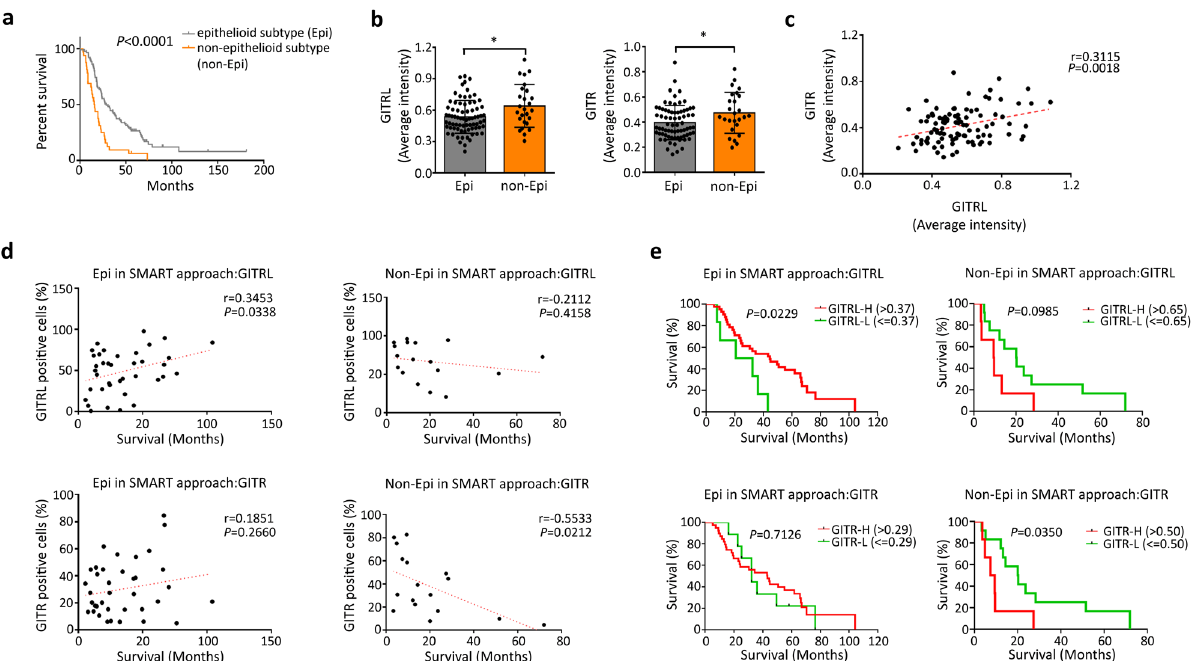
Fig. 6 GITR/GITRL were highly expressed in nonepithelioid MPM and negatively correlated with survival after the SMART approach. a Kaplan – Meier survival analysis of all MPM patients demonstrates that patients with epithelioid subtype (Epi.) had better survival than those with nonepithelioid subtype (non-Epi.) with a median survival of 28.6 (Epi.) versus 15.9 months (non-Epi.) ( P < 0.0001). b GITR and GITRL levels by immunohistochemistry in epithelioid and nonepithelioid MPM; immunohistochemistry results were quanti fi ed by De fi niens Tissuestudio 4.0 software. * P < 0.05, determined by Mann – Whitney U test. c Correlation between expression of GITR and GITRL ( p = 0.0018, r = 0.3115). d Risk analysis of patients with epithelioid